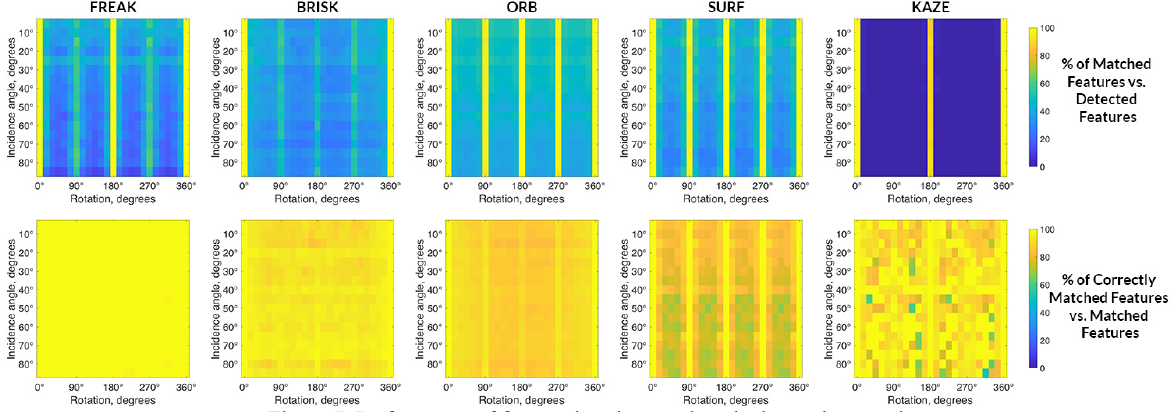
Figure 7. Performance of feature descriptors when the image is